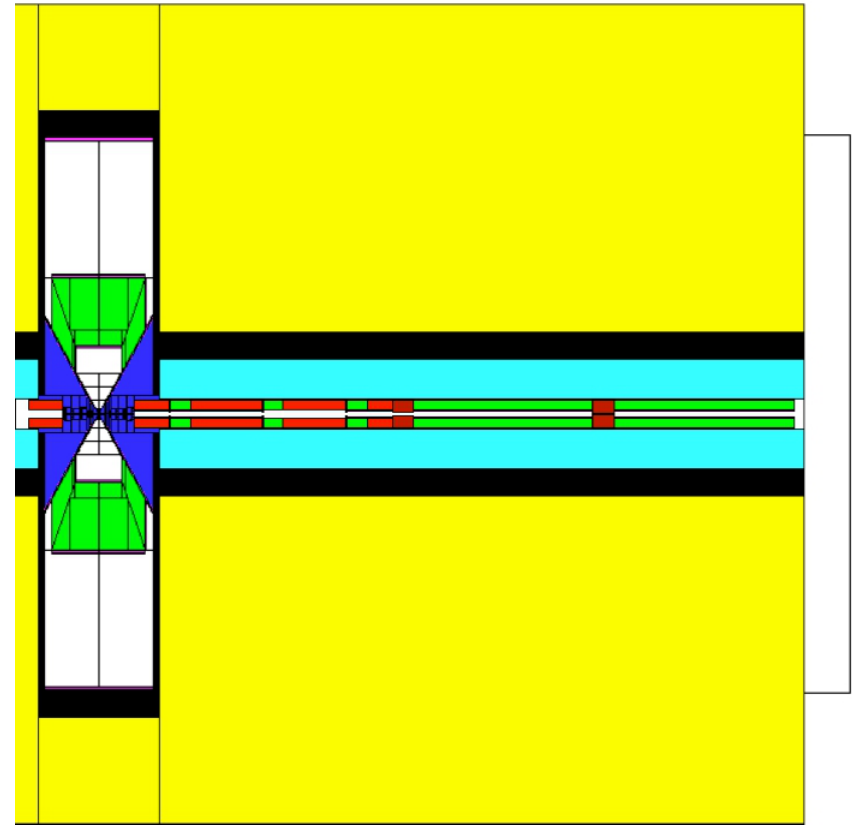
FIG. 63. (Color) Region up to 130 m from the IP, of the 2 1 2 TeV interaction region modeled in GEANT . The triangular blue regions represent tungsten shielding. On the right-hand side of the figure, the red areas represent quadrupoles in the beam line. The areas around the IP represent the various detector volumes used in the calculations of particle fluences. The detector (white and green areas) is 10 m in diameter and 20 m